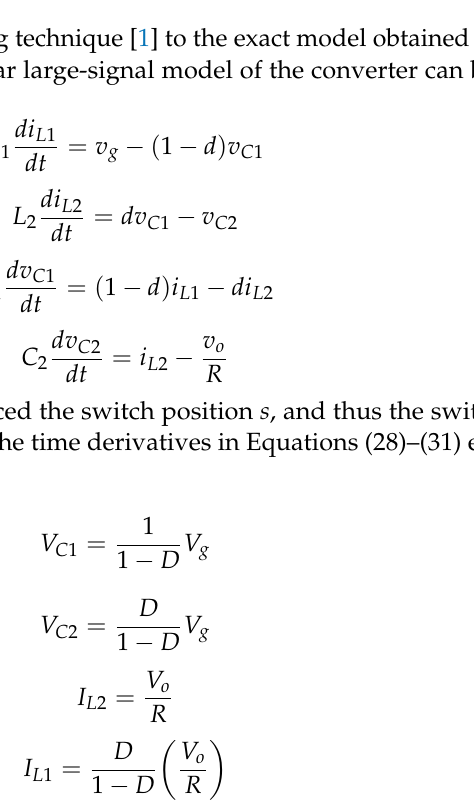
Figure 8. Equivalent circuits when the transistor is ( a ) on and ( b ) off.